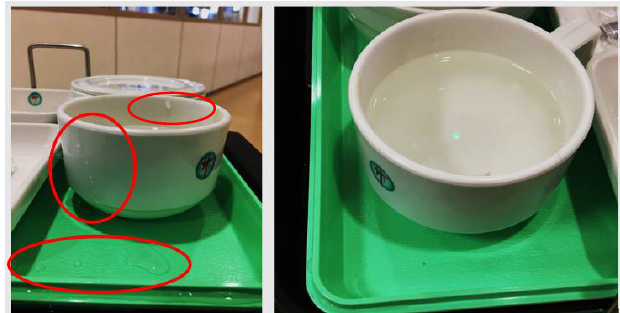
Figure 4. Navigation’s move base (left) and with VelProSMACH_V1 (right).